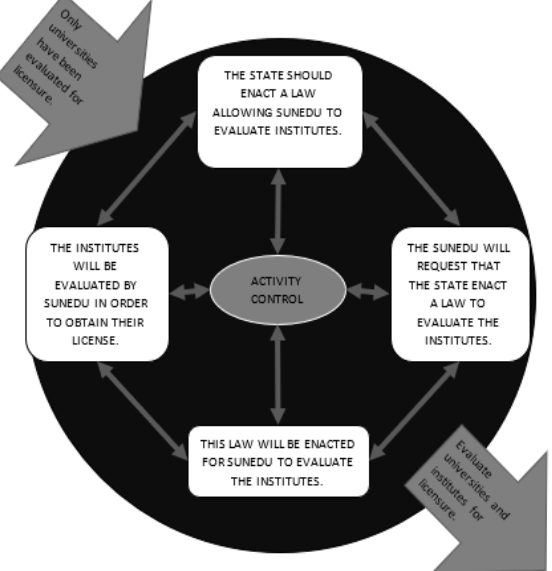
Fig. 10. Conceptual model applied to SUNEDU